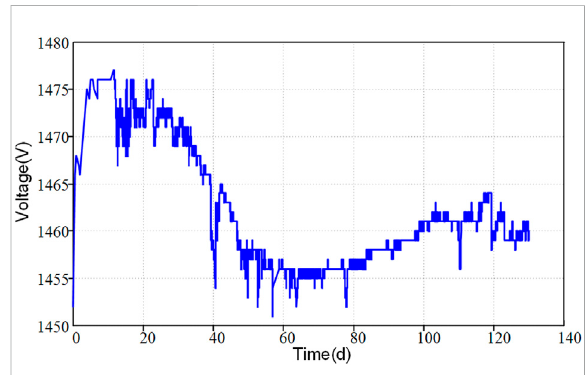
FIGURE11 The curve of the operating voltage of the electron multiplier with time in the early stage.